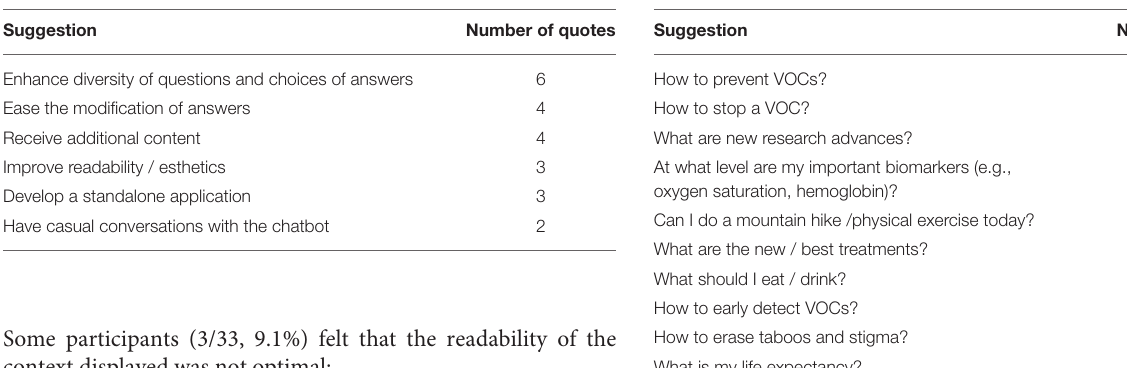
TABLE 6 | Summary of suggestions of improvements. TABLE 7 | Patients’ suggestions for information that TREVOR should